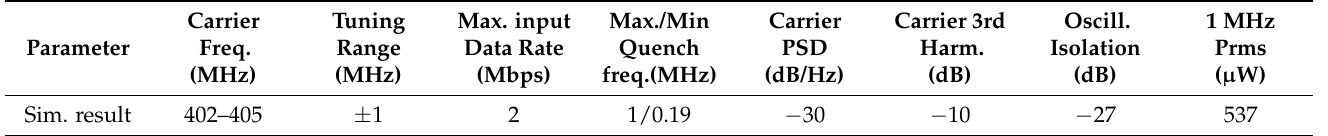
Figure 17. Complete transmitter performance for input data rate 1Mbps with quench frequency sig- nal 1MHz.